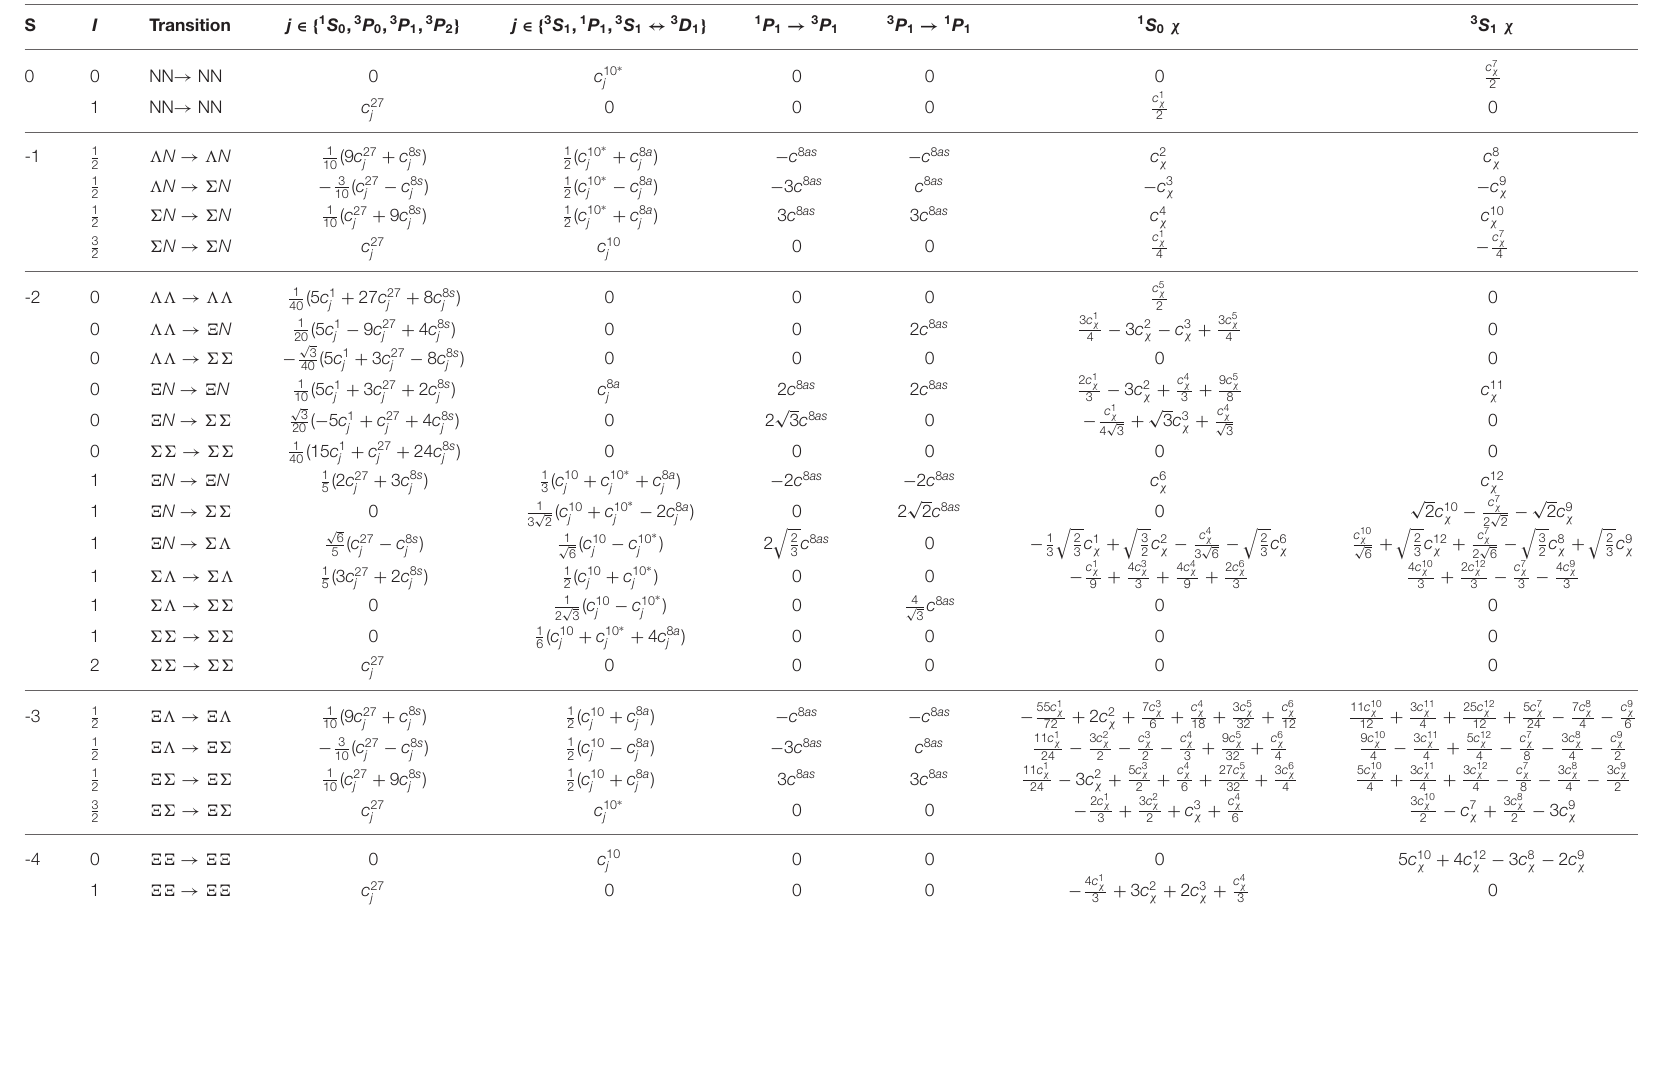
TABLE 3 | SU(3) relations of pure baryon-baryon contact terms for non-vanishing partial waves up to O ( q 2 ) in non-relativistic power counting for channels described by strangeness S and total isospin I [32].